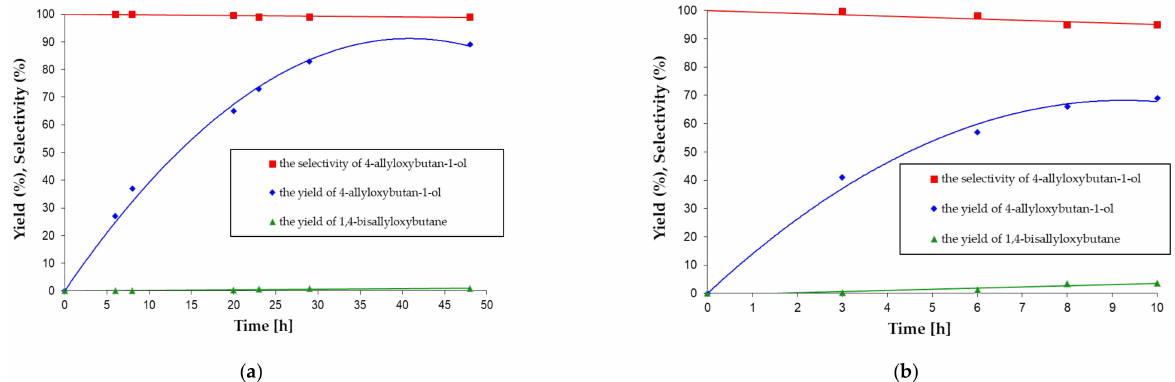
Figure 1. The time course reaction profile of O -allylation of butane-1,4-diol by allyl chloride in the presence of 50% NaOH(aq) under ( a ) non-catalyzed or ( b ) catalyzed by 0.1 mol% of Bu 4 N + HSO 4 − conditions (the reaction conditions: see Table 1 entries 16–17 and 13–15, respectively).